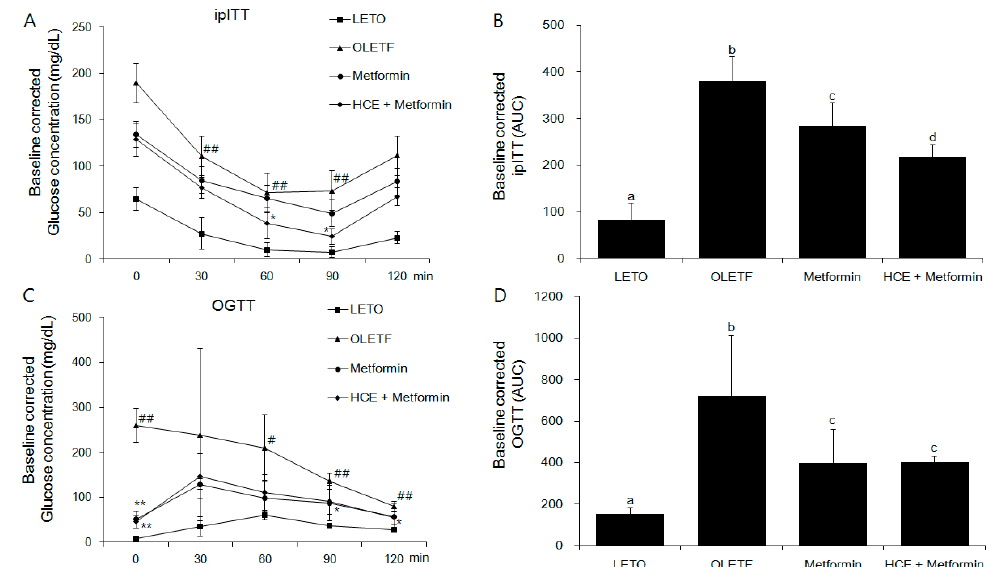
Figure 2. Impact of metformin either alone or in combination with HCE on the insulin sensitivity and